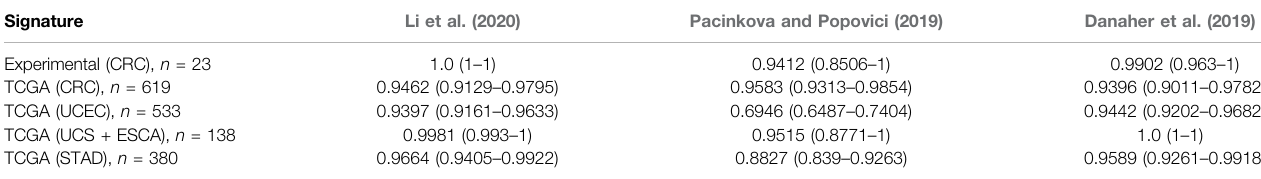
TABLE 2 | AUC scores and (95% con fi dence interval) for three RNAseq MSI gene signatures.